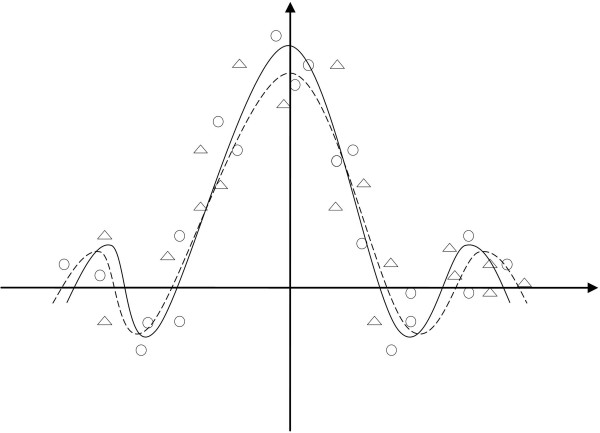
Illustration of the support vector machine method used for regression. Given a set of observed training data (circles and triangles), which are sampled from the hidden original function f(x) (solid line) and may be polluted by noise during this procedure, the SVR constructs the fitted regression function φ(x) (dashed line) by solving the corresponding optimal problem with constrains. The support vectors and non-support vectors are denoted with circles and triangles, respectively.